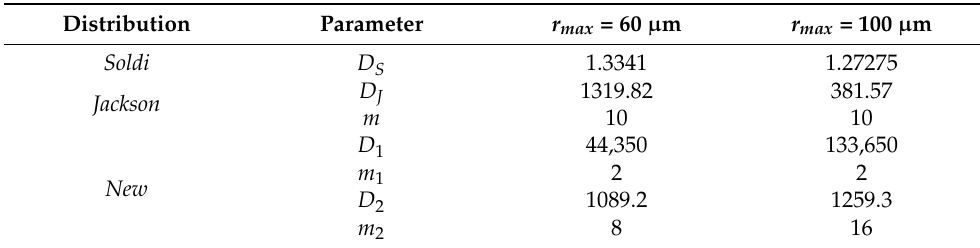
Table 4. Values required for each parameter of Soldi , Jackson and New distribution functions to obtain porosity of 18.75% with alternating radius water wet bundle of capillary tubes model with radial and length factors of 0.7 and 0.2, respectively, when dr c = 0.1 µ m. Number of significant figures varies due to the requirement to match porosity